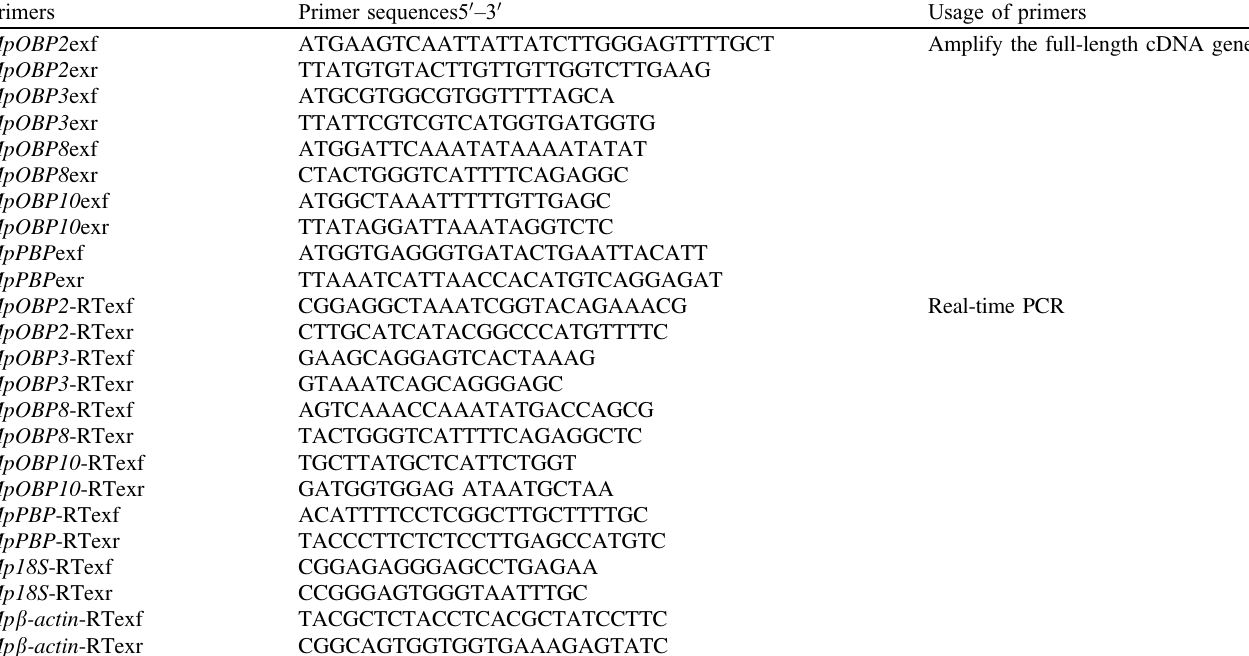
Table 1. Primers used for PCR ampli fi